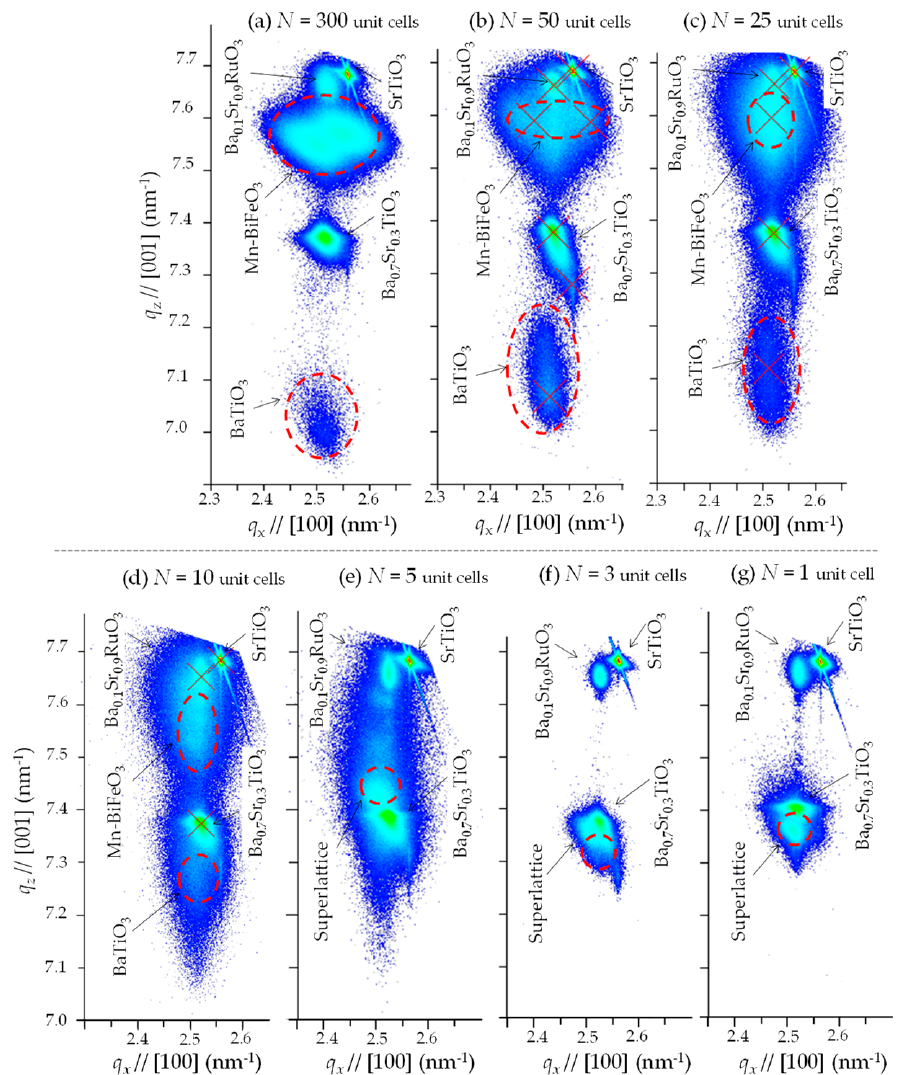
Figure 4. High-resolution XRD-RSMs around 103 reflection for ( a ) N = 300, ( b ) N = 50, ( c ) N = 25, ( d ) N = 10, ( e ) N = 5, ( f ) N = 3 and ( g ) N = 1, where the vertical axis is q z //[001] and the horizontal axis is q x //[100], where N denotes the number of ABO 3 unit cells in the two layers of Mn-BiFeO 3 and BaTiO 3 comprising the superlattice. Here, [001] and [100] are the crystallographic directions of the (100) SrTiO 3 substrate.